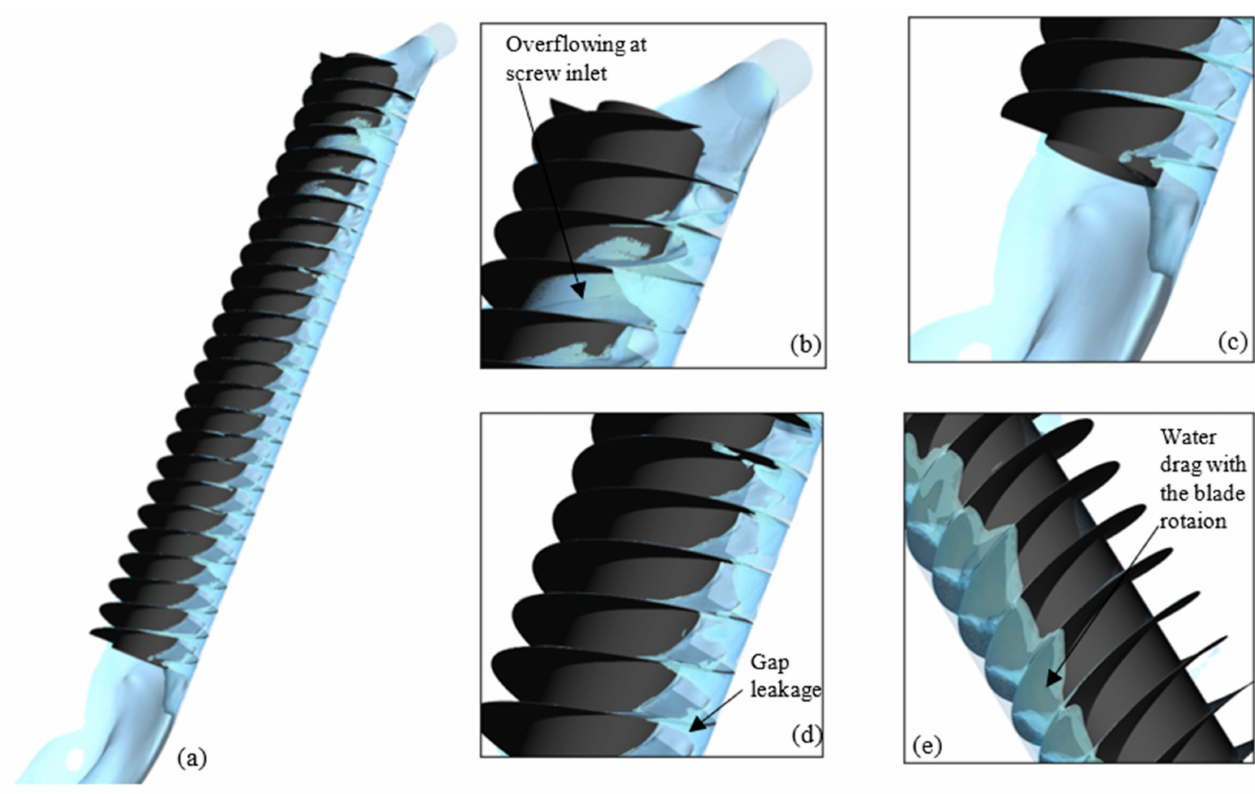
Figure 10. Simulated water flow inside the AST (0.5 water volume fraction). ( a ) isometric view ( b ) screw inlet ( c ) screw end ( d ) front view of middle screw ( e ) back view of middle screw.